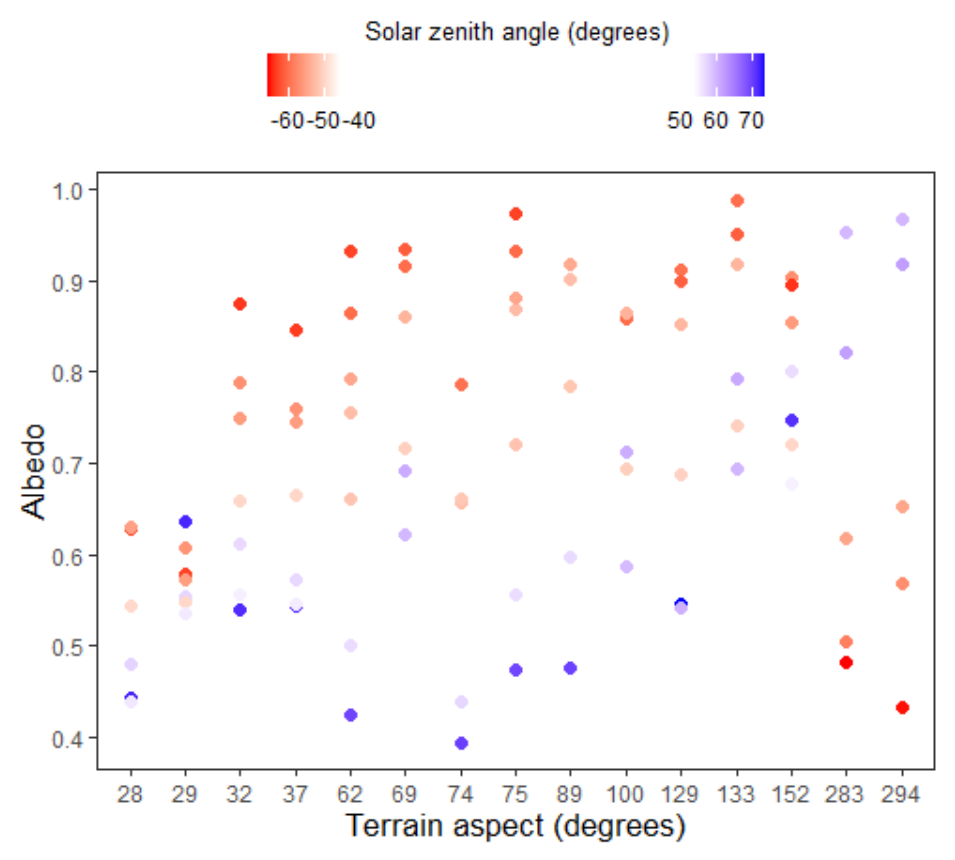
Figure 4. Albedo observations for each of the 15 Norway spruce tree objects, represented by their terrain aspect angles (defined to true north). The color grading represents the solar zenith angle (in degrees), where negative angles correspond to measurements before solar noon. Table 3. Pearson correlation coefficients and corresponding p -values between albedo and solar angles, terrain slope angles and the snow-masking of the tree objects ( A shadow